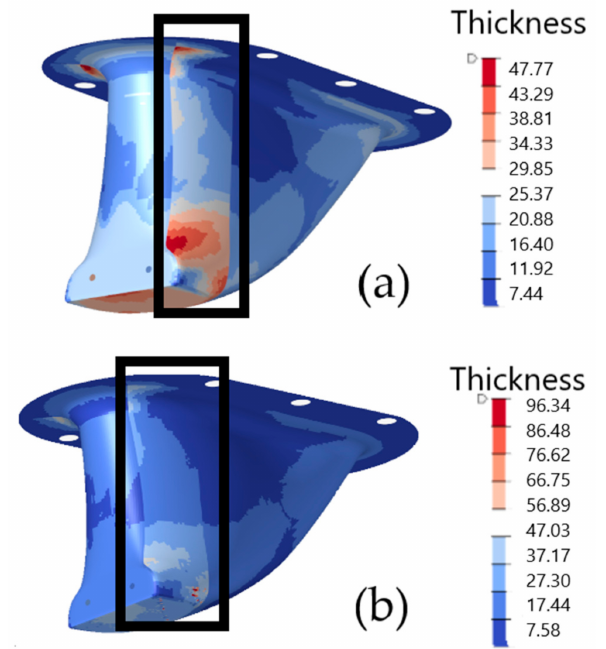
Figure 16. Thickness contour plots in the finger joint area for the partitioned no drape ( a ) and partitioned draped models ( b ) following topology optimization.